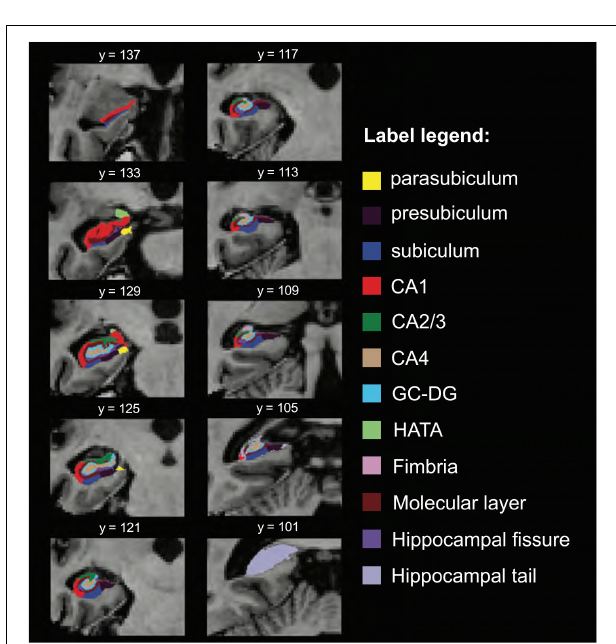
FIGURE 2 | Additional views, hippocampal subfield delineation at 7 Tesla. Coronal view of hippocampal subfield segmentation (radiological display convention) at multiple locations of the same hippocampus. CA, cornu ammonis; GC-DG, granule cell layer of the dentate gyrus; HATA, hippocampus-amygdala-transition-area.